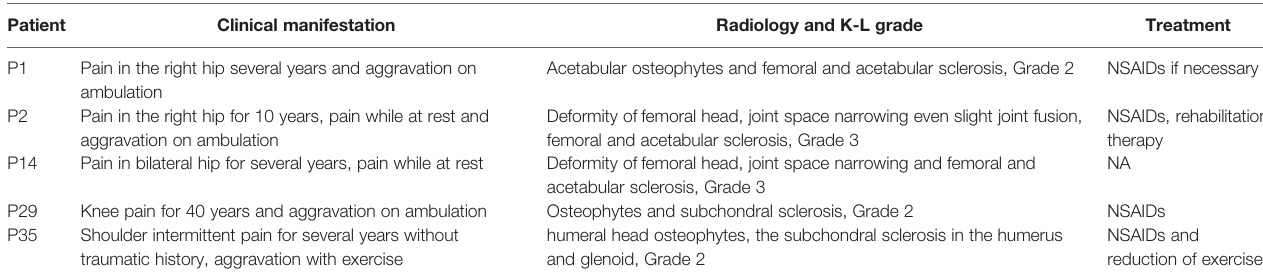
TABLE 3 | Clinical manifestations, radiology and treatment of patients with